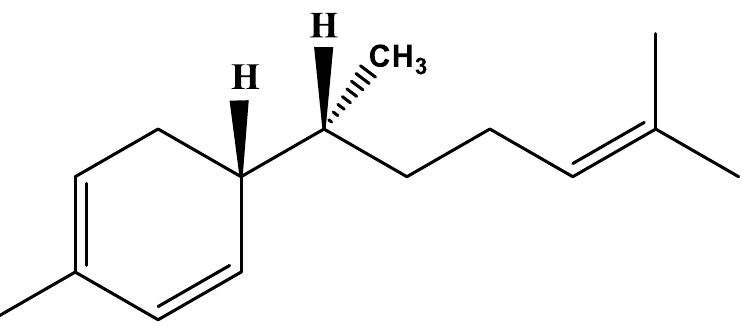
Figure 1. Structure of 7-epi zingiberene (C 15 H 24 ) showing the conjugated double bonds in the